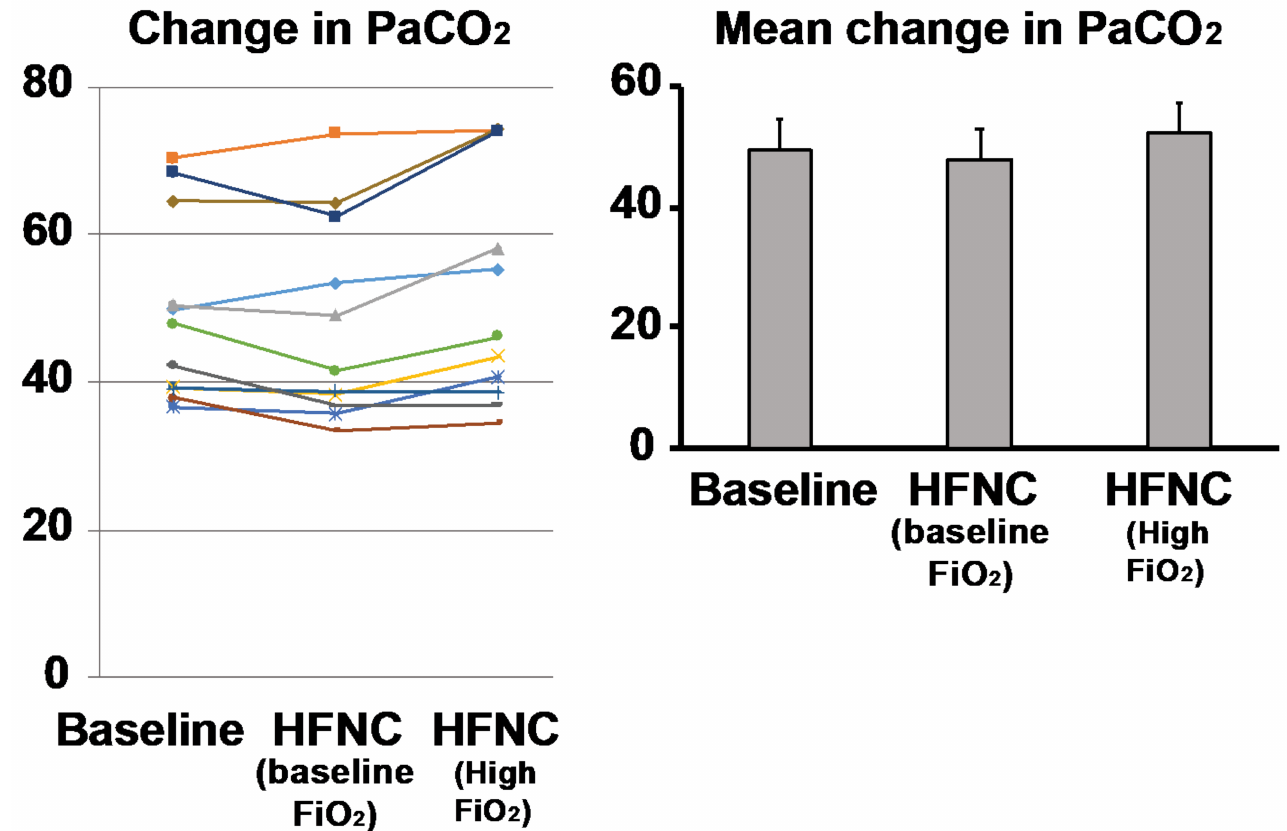
Figure 3. Response to baseline oxygen delivery via high flow nasal cannula (HFNC) in COPD patients. Comparison of baseline PaCO 2 after being placed on HFNC at baseline FiO 2 showed that the majority of subjects ( n = 7; 63.6%) experienced a decrease in PaCO 2 , while others either stayed the same ( n = 2, 18%) or developed increased PaCO 2 ( n = 2; 18%). After HFNC was increased by an FiO 2 30% above baseline there were increases in hypercapnia in the majority ( n = 7, 63.6%). The baseline hypercapnic subjects (defined as resting PaCO 2 > 45, n = 6) were more likely to increase their PaCO 2 ( n = 5, 83.3%). Each colored line represents the individual response of the